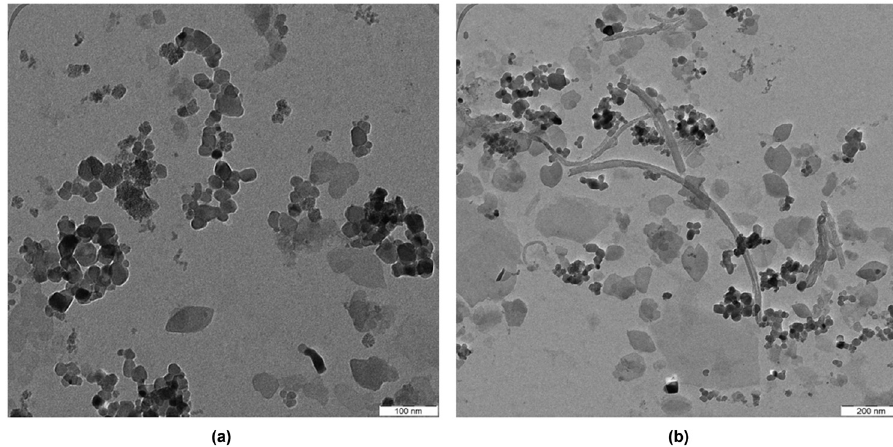
Figure 9: TEM images of unique spherical shape of BNC after acid hydrolysis treatment: ( a ) 40,000 × magni fi cation and ( b ) 20,000 × magni fi